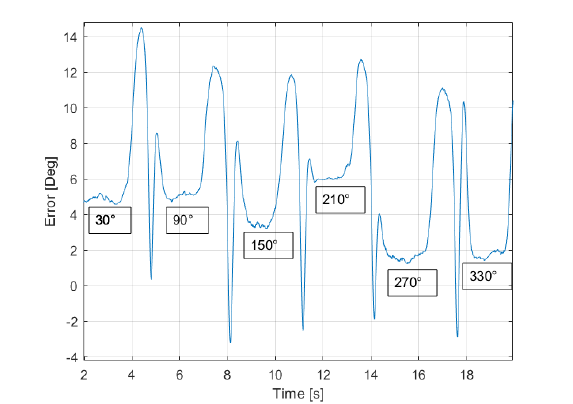
Figure 12. Stanstill position error at imposed rotor